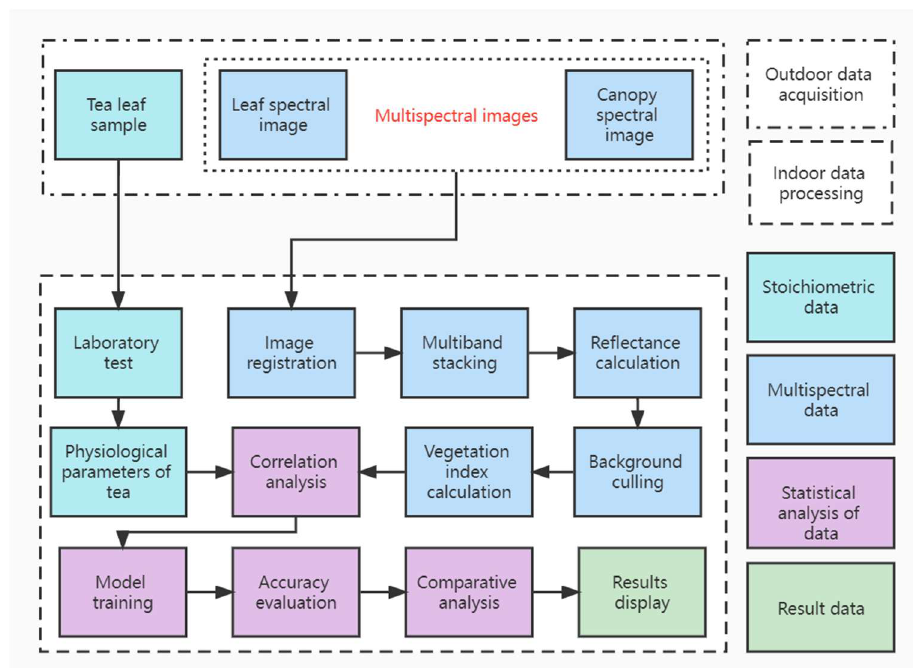
Figure 2. Experimental